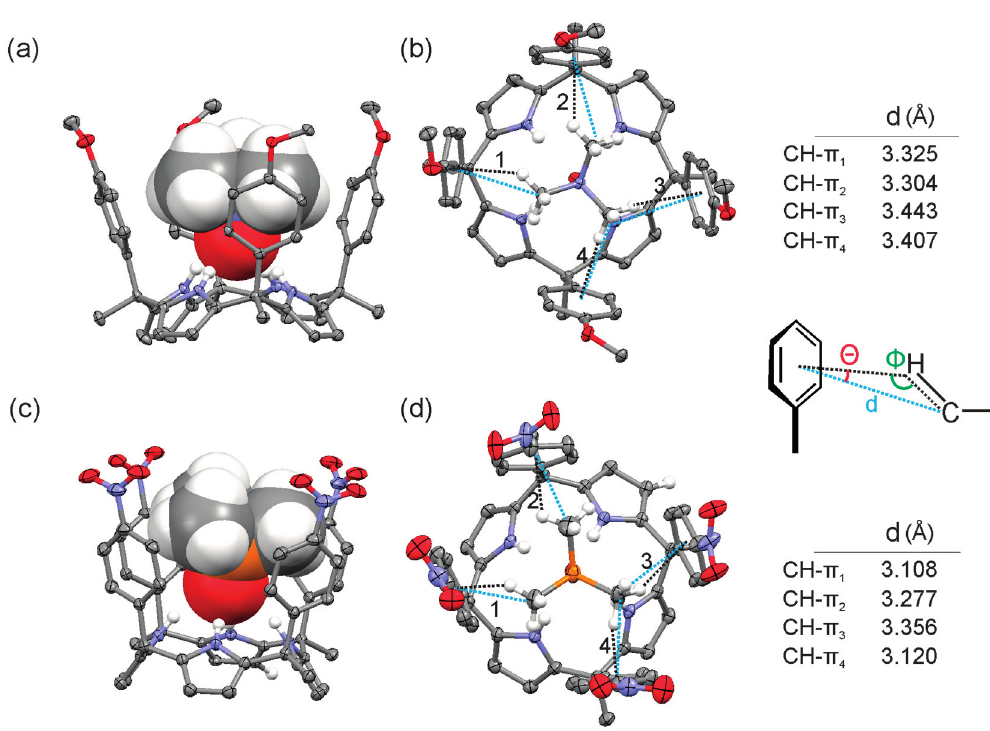
Figure 7. Side ( a , c ) and top ( b , d ) views of the X-ray structure of 2a @ 1e and 2b @ 1f complexes, respectively. Distances and angles related to the CH- π interactions are